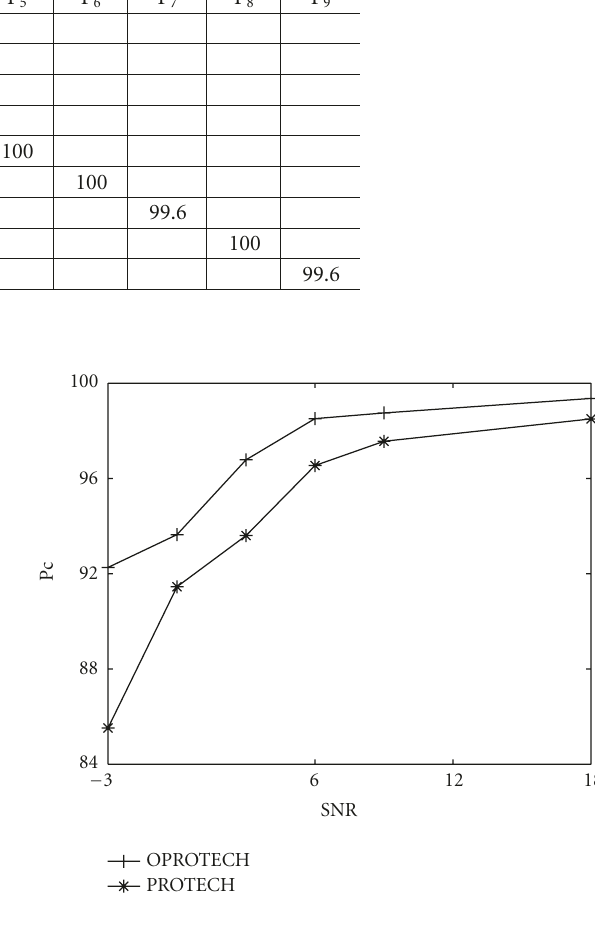
Figure 5: Comparison between the performances of the nonopti- mized technique (PROTECH) and optimized technique (OPRO-